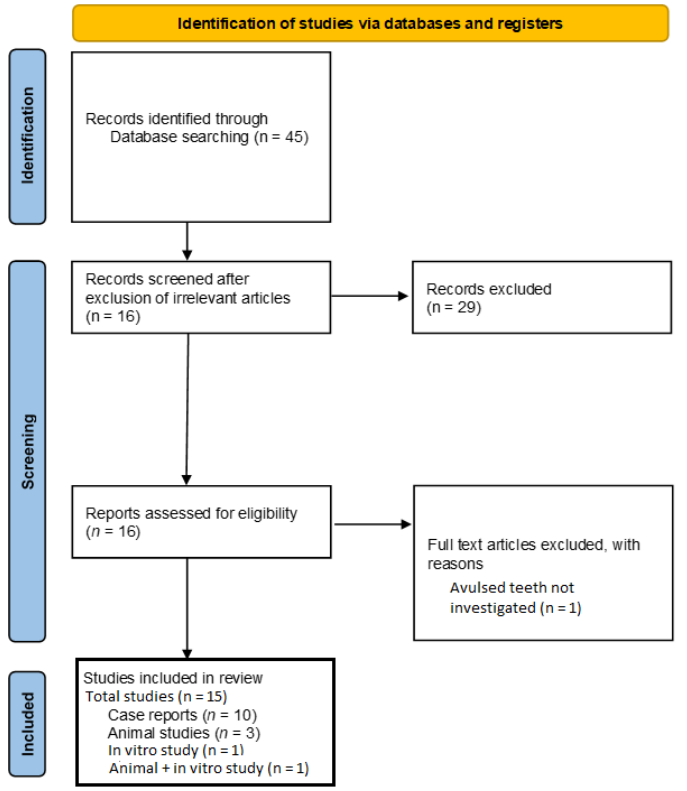
Figure 1. A PRISMA flow diagram for the search methodology employed for this systematic re- view.